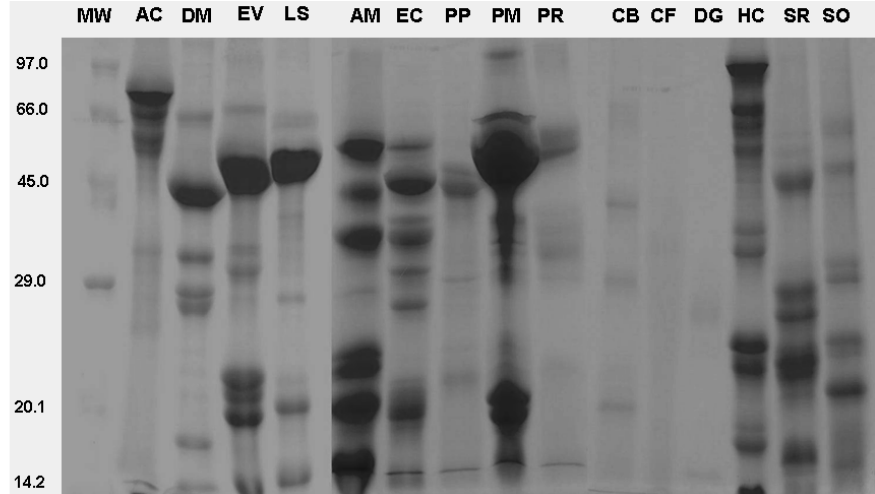
Fig. 1 – Electrophoresis of water extract proteins of Amburana cearensis (AC), Dioclea mega- carpa (DM), Erythrina velutina (EV), Lonchocarpus sericeus (LS), Anadenanthera macrocarpa (AM), Enterolobium contortisiliquum (EC), Parkia platycephala (PP), Piptadenia moniliformis (PM), Plathymenia reticulata (PR), Caesalpinia bracteosa (CB), Caesalpinia ferrea (CF), Dimor- phandra gardneriana (DG), Hymenaea courbaril (HC), Senna rugosa (SR), Senna obtusifolia (SO). A total of 50 μ g of protein was applied in the